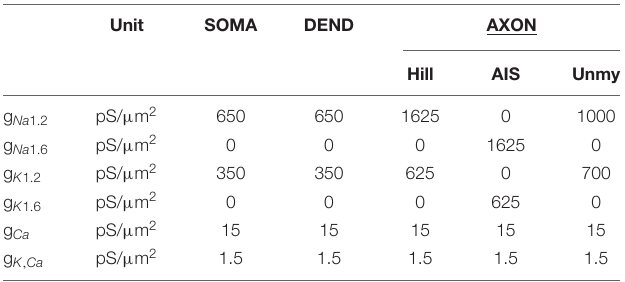
TABLE 2 | Ionic current densities along the neural membrane for RGC models based on data from Fohlmeister et al. (2010) and Werginz et al. (2020).